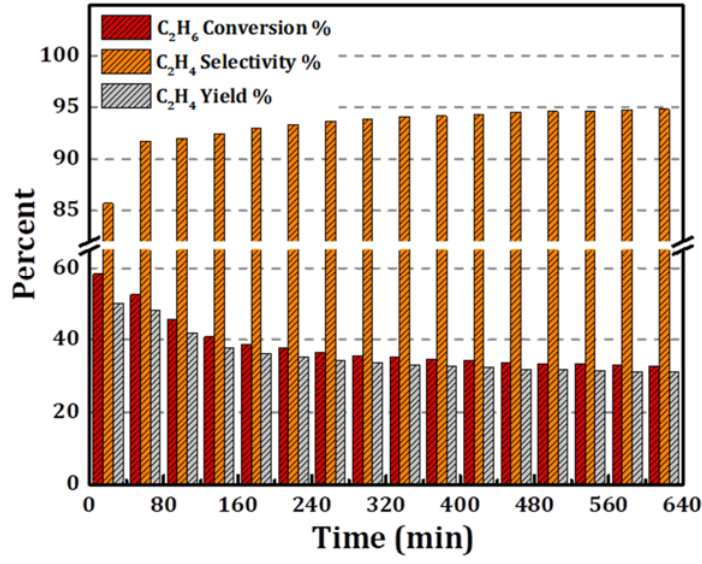
Figure 9. Ethane conversion, ethylene yield and selectivity versus time-on-stream over Cr(8) / Ti(2.2)–Si Nanocomposite catalyst at 700 °C.